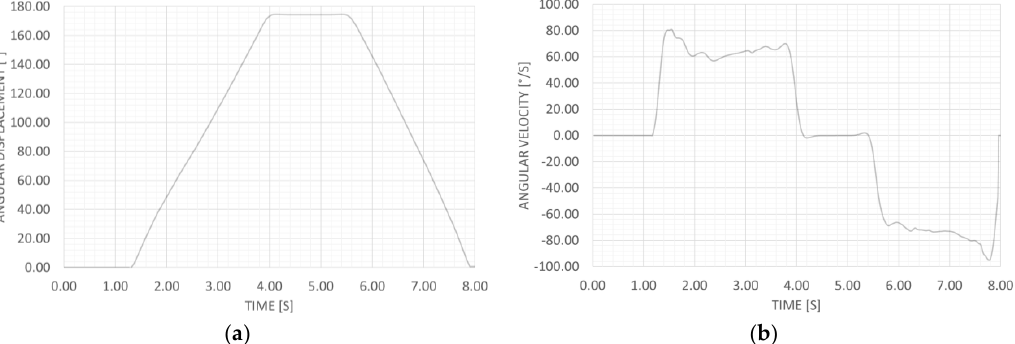
Figure 14. Motor unit experimental test results: ( a ) Angular displacement, ( b ) Angular velocities. Using the same hardware to assess a prototype of the limb with a 48 mm pulley, 1.38